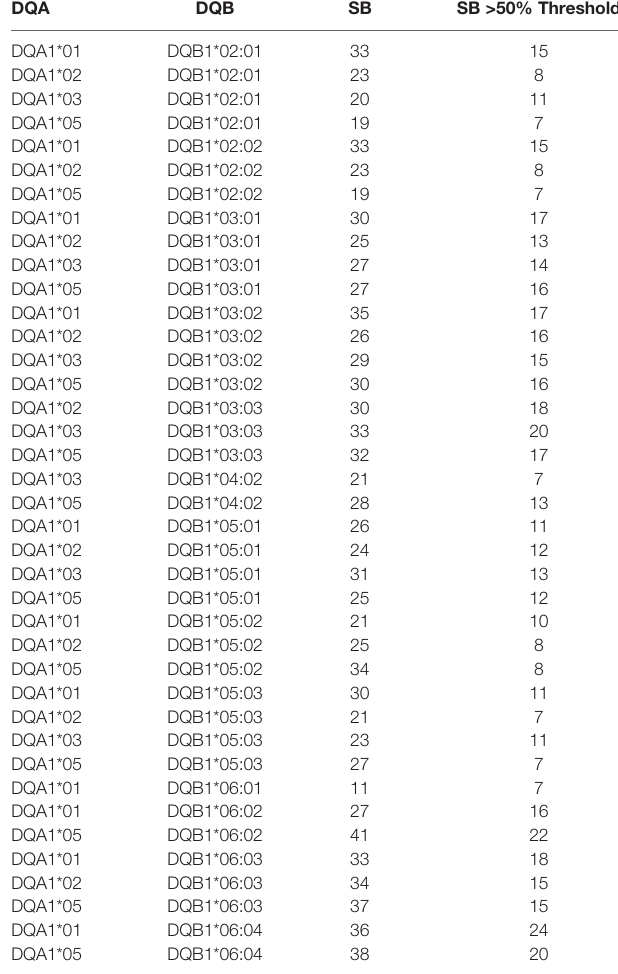
TABLE 2 | Number of strong binders for HLA DQA1-DQB1 alleles identi fi ed in the enrolled vaccinees. DQA DQB SB SB >50% Threshold DQA1*01